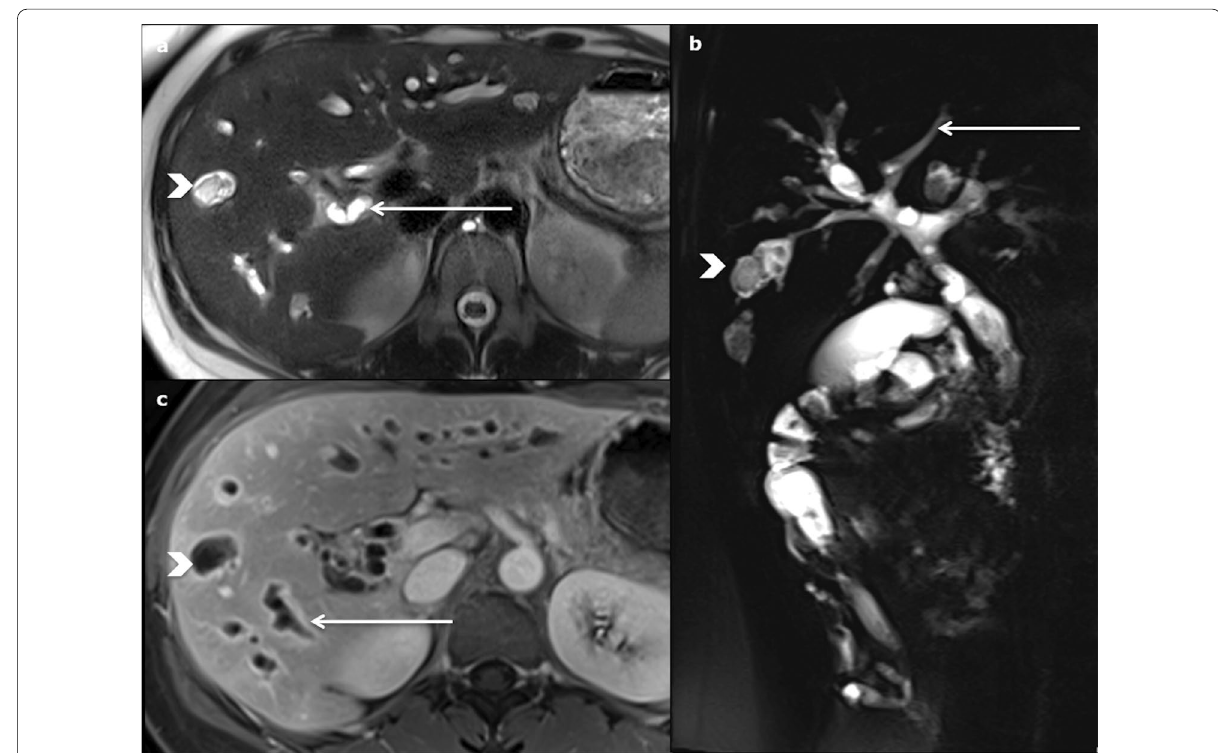
Fig. 10 Caroli disease in a 24-year-old male. a Axial magnetic resonance imaging in T2 and ( b ) in T1 on portal venous phase show both fusiform (arrows) and connected round (arrowheads) dilatations, better depicted on magnetic resonance cholangiopancreatography images ( c ). There is no associated sign of fibrosis